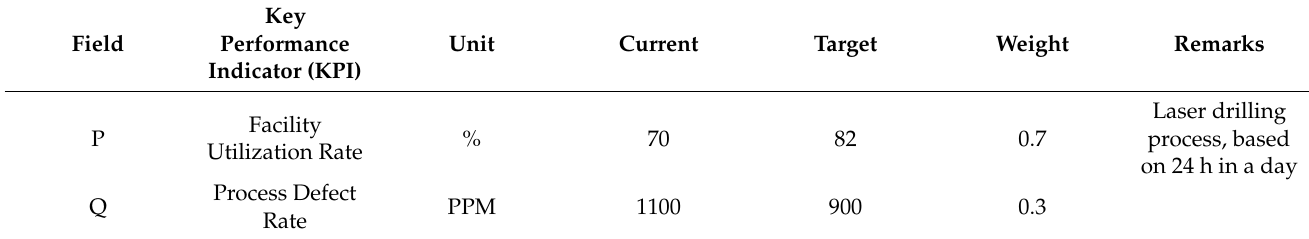
Table 1. The KPIs of facility utilization rate and process defect